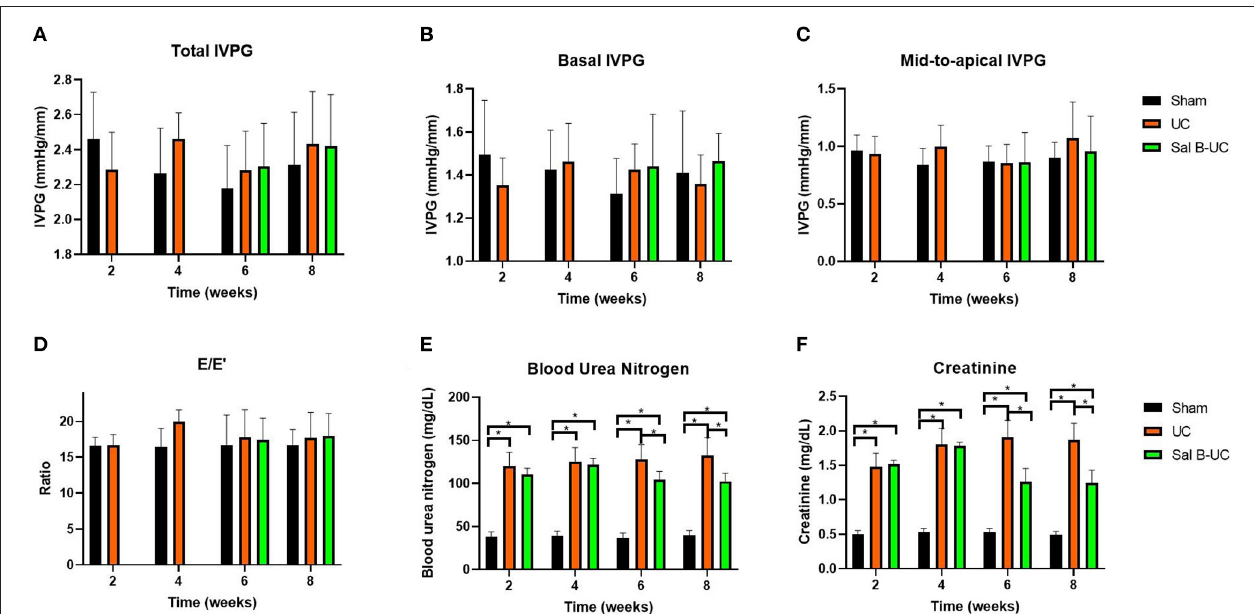
FIGURE 1 | Novel echocardiography and kidney function in uremic cardiomyopathy, sham operation, and Sal B-treated rats. Novel echocardiographic measurements in the sham, UC, and Sal B-UC groups. Two-way ANOVA was performed to test the differences between groups and time points, Tukey’s post-hoc test used group comparisons. * Indicate a significant difference between groups, p < 0.05. (A) Total IVPG, the mix of basal and mid-to-apical intraventricular pressure gradients. (B) Basal IVPG, the basal intraventricular pressure gradients. (C) Mid-to-apical IVPG, the mid plus apex intraventricular pressure gradients. (D) E/E ′ , ratio of E to E ′ . (E) creatinine. (F) BUN, blood urea